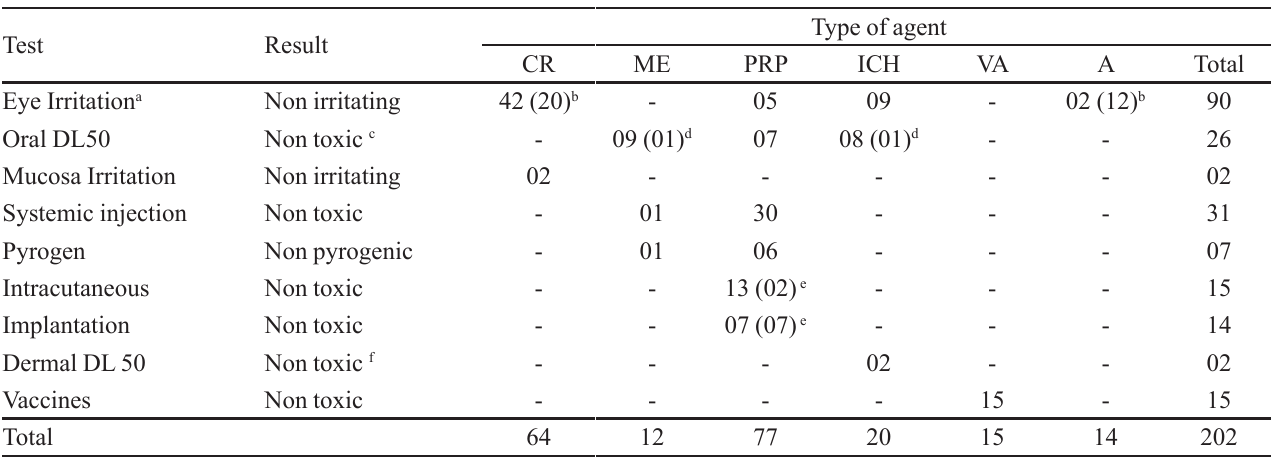
TABLE IX – Summary of results for 202 tests not outlined above, from the total of 602 tests conducted at Cedeme from January 1986 to December 2000 (CR = cosmetics and related agents; ME = medicines; PRP = plastics, rubber and other polymers; ICH = industrial chemicals ; VA = vaccines; A =